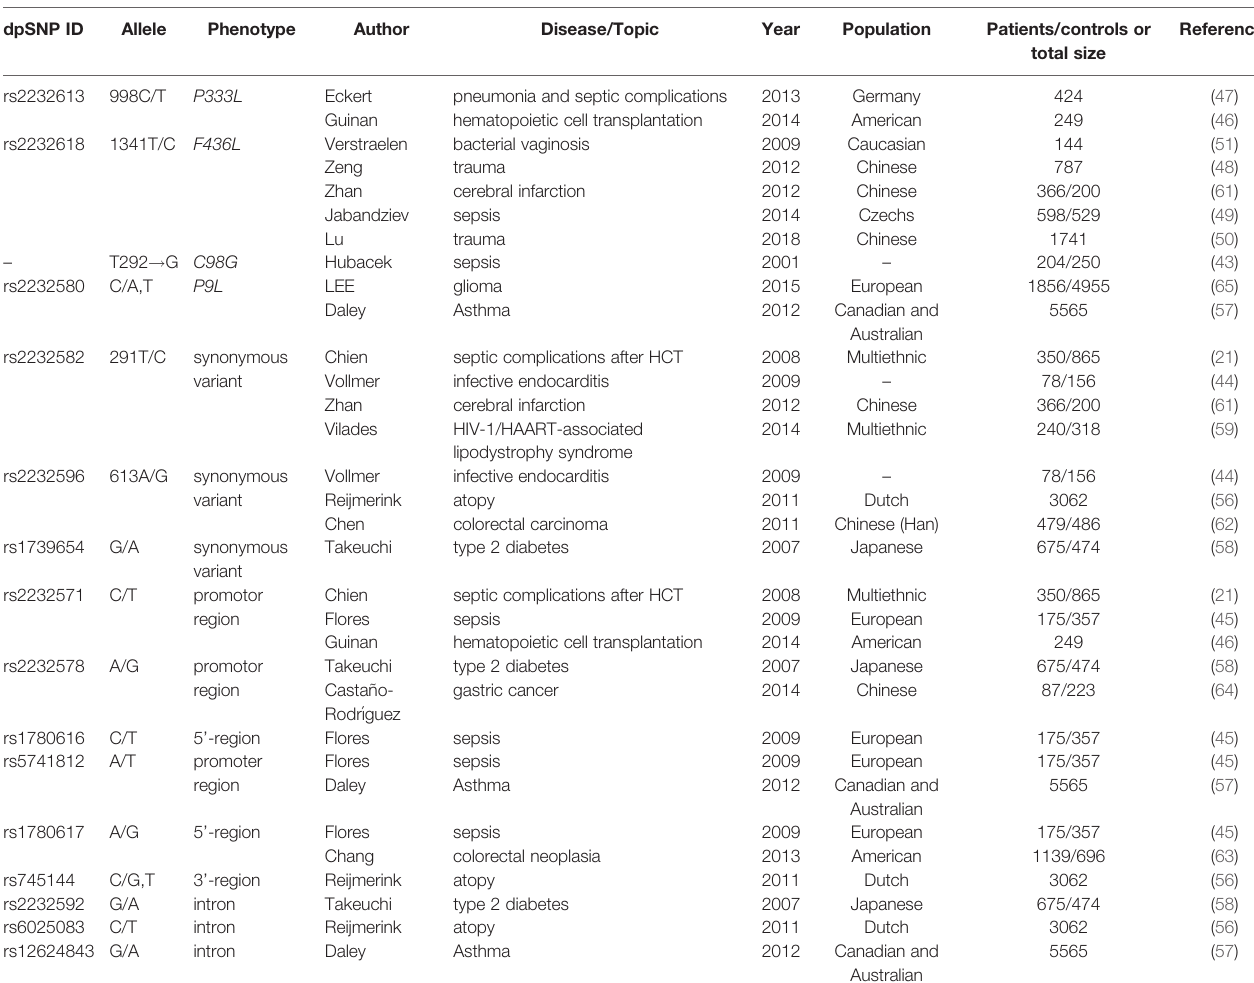
TABLE 3 | Summary of Lipopolysaccharide Binding Protein (LBP) SNPs correlated with corresponding disease. dpSNP